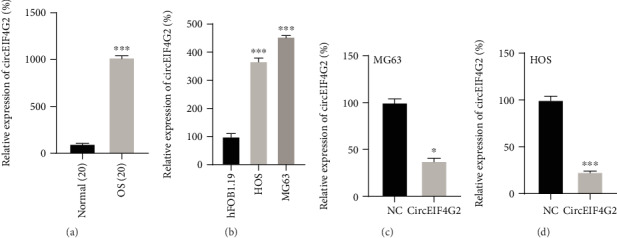
CircEIF4G2 was upregulated in OS. (a) CircEIF4G2 expression in OS tissues was higher than that in normal tissue. (b) CircEIF4G2 expression was upregulated in OS cells. (c and d) CircEIF4G2 expression levels were reduced in MG63 and HOS after transfecting with siRNAs against circEIF4G2. ∗p < 0.05.